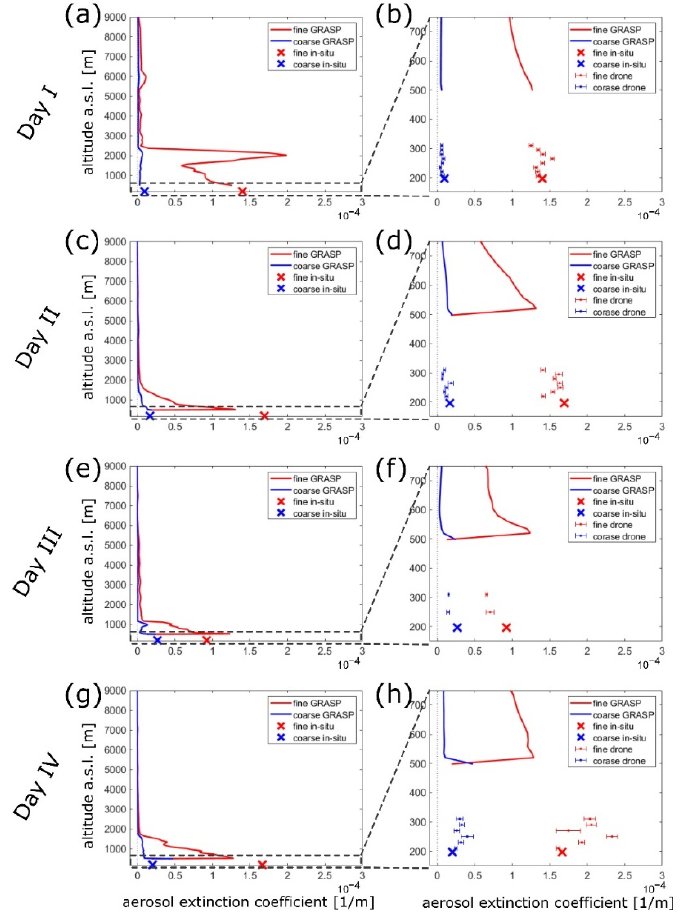
Figure 1. Aerosol extinction obtained from GRASP (LIDAR and sunphotometer data), in-situ particle size distribution supported by Mie theory (SMPS and APS data), and UAV-based optical particle counting (OPC data normalized to APS+SMPS derived values at the ground). The left-hand side plots ( a , c , e , g ) depict the full height of the profiles throughout the troposphere while the values near the ground are depicted on the zoomed-in right-side plots ( b , d , f , h ). Moreover, drone measurements with corresponding standard deviations are included in these zoomed-in